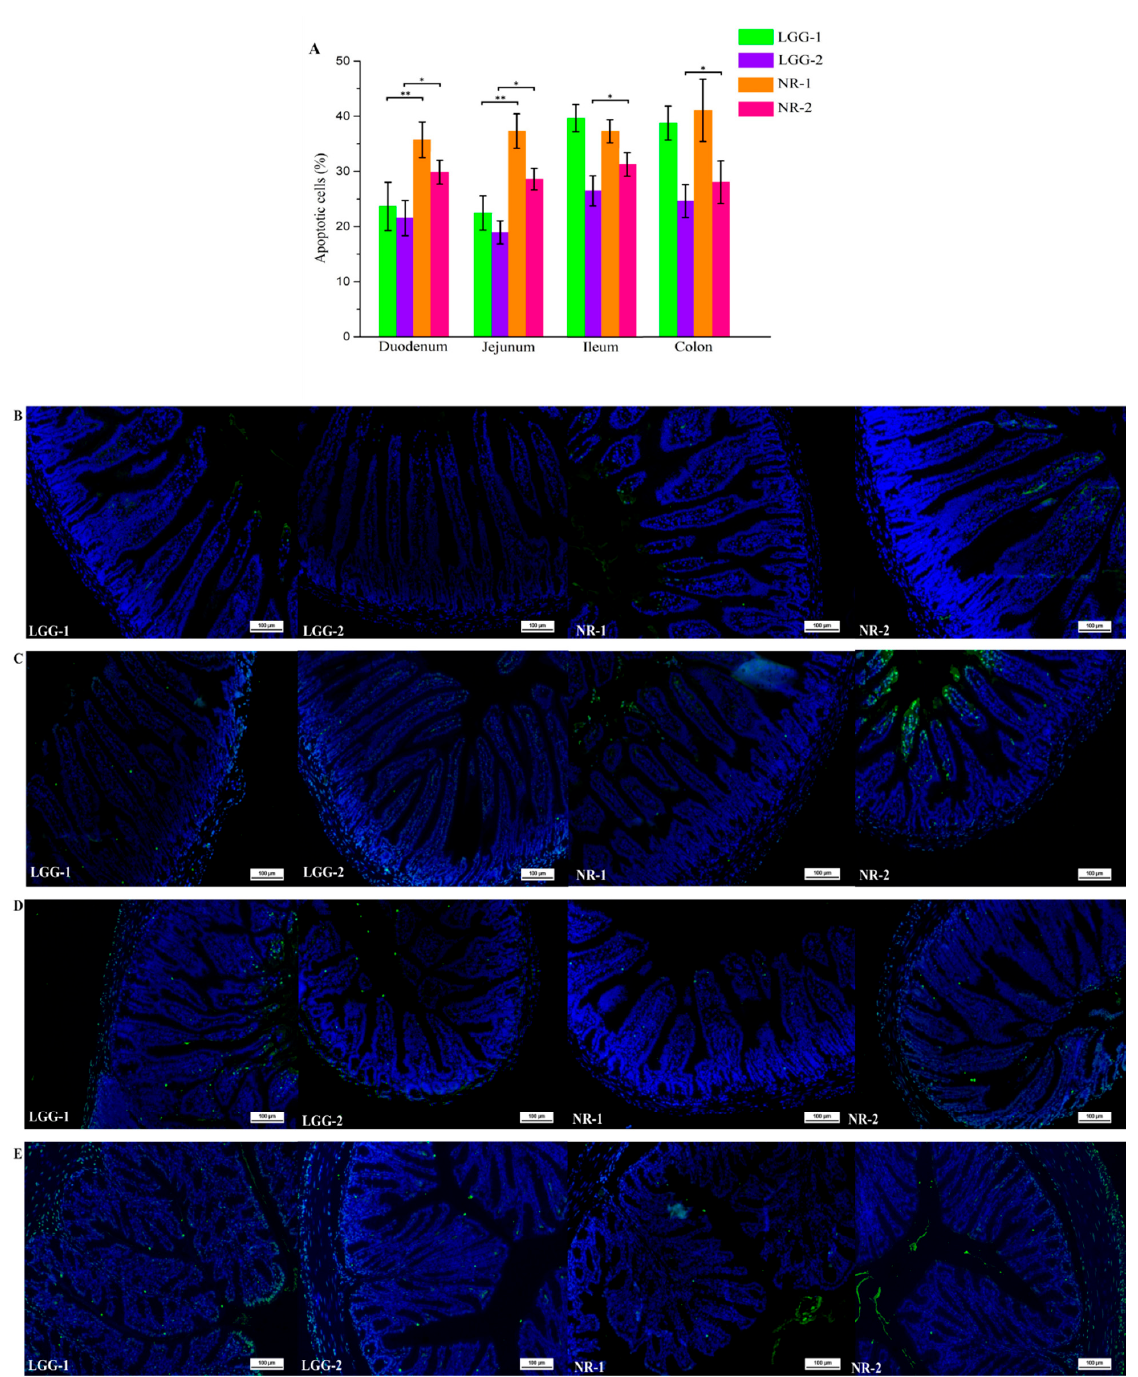
Figure 2. ( A ) TUNEL assay on the number of apoptotic cells in duodenal, jejunum, ileum and colon. TUNEL assay on the pathological status in ( B ) duodenal; ( C ) jejunum; ( D ) ileum; ( E ) colon. (* p < 0.05; ** p < 0.01; *** p < 0.001).